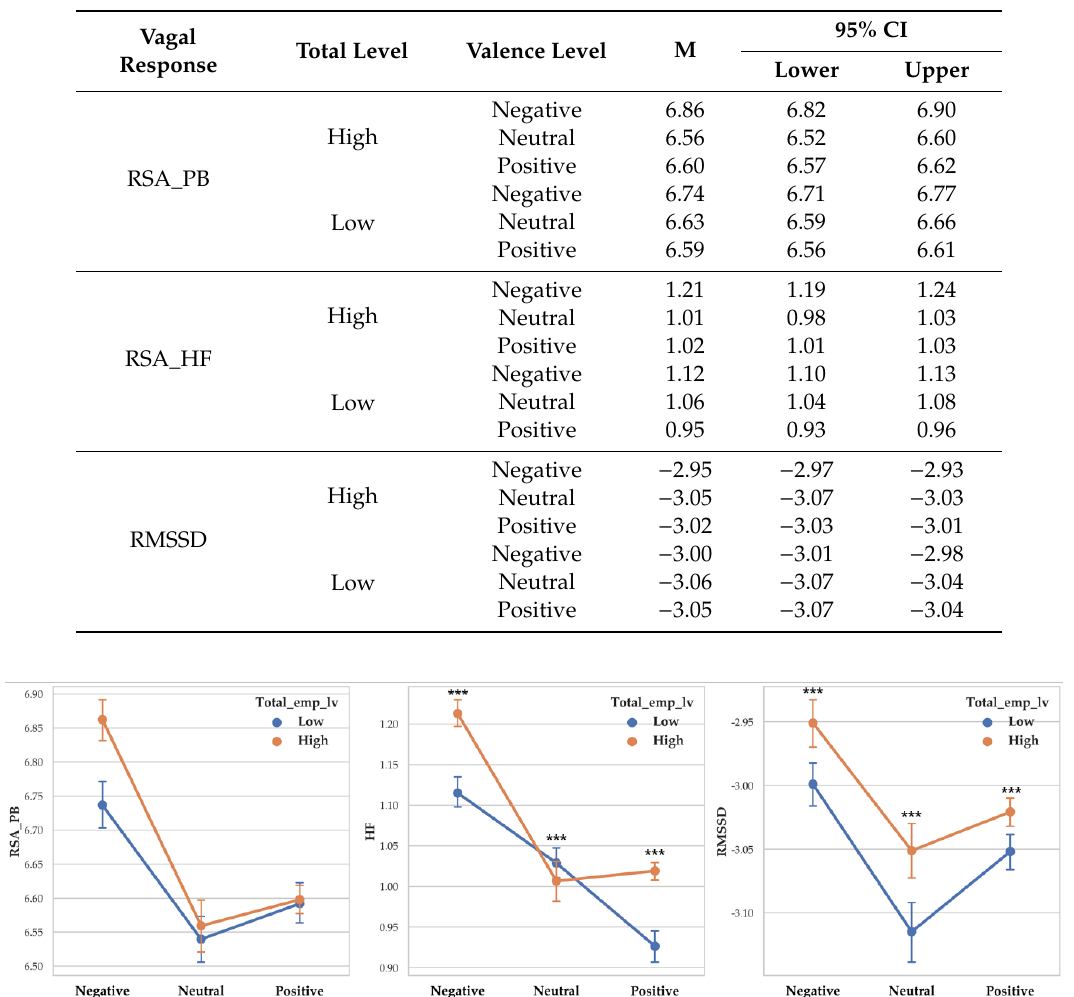
Table 10. Descriptive statistics for vagal response depending on total empathy level and valence. M = Mean, SD = Standard deviation. 95% CI = 95% of confidence interval.